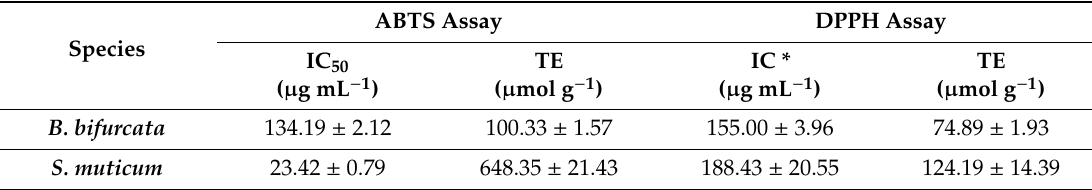
Table 3. Antioxidant activity of B. bifurcata and S. muticum total lipid extracts expressed as inhibitory concentration (IC) values ( μ g mL − 1 ) for ABTS and DPPH assays, and Trolox Equivalents (TE) ( μ mol g − 1 ) for each assay.